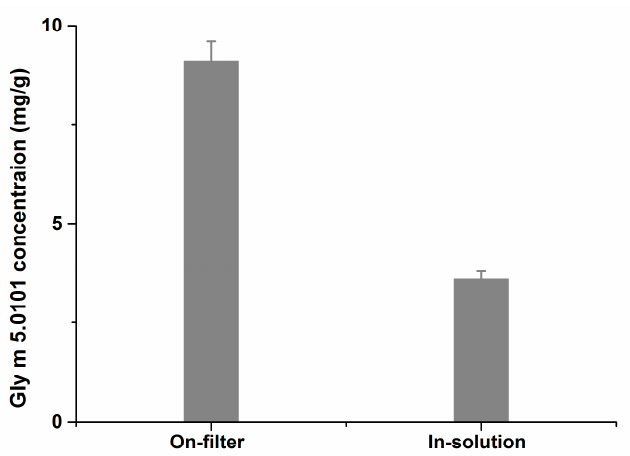
Figure 4. Comparison of different tryptic digestion patterns (on-filter and in-solution) from the soybean protein extraction.